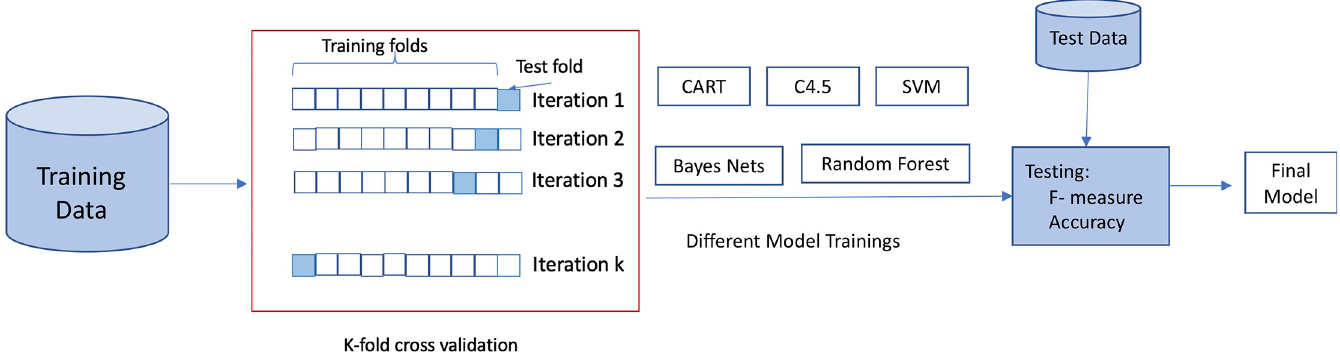
Fig 6. Scheme of the